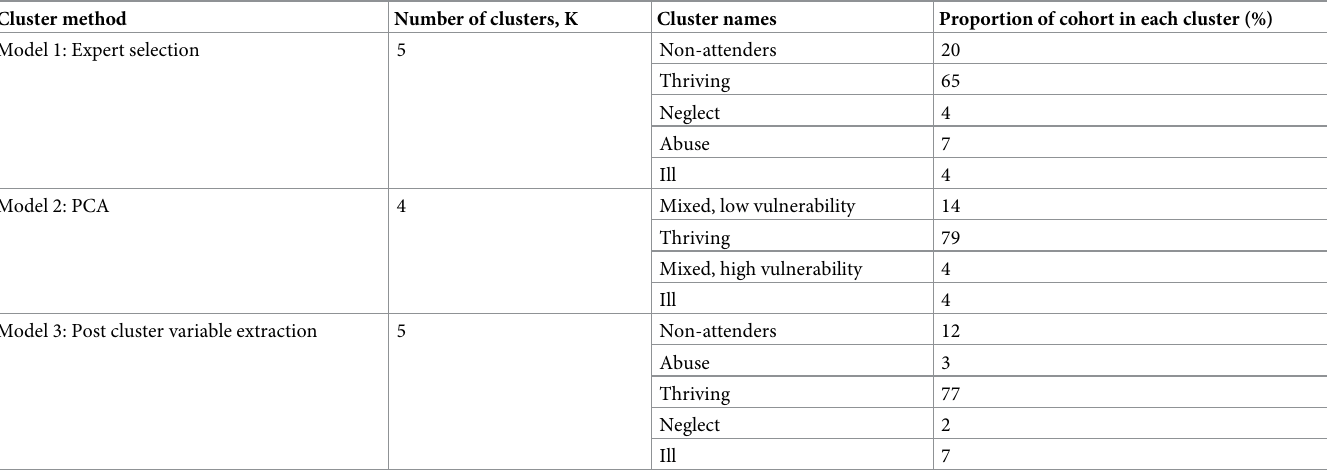
Table 2. Result for three clustering methods.